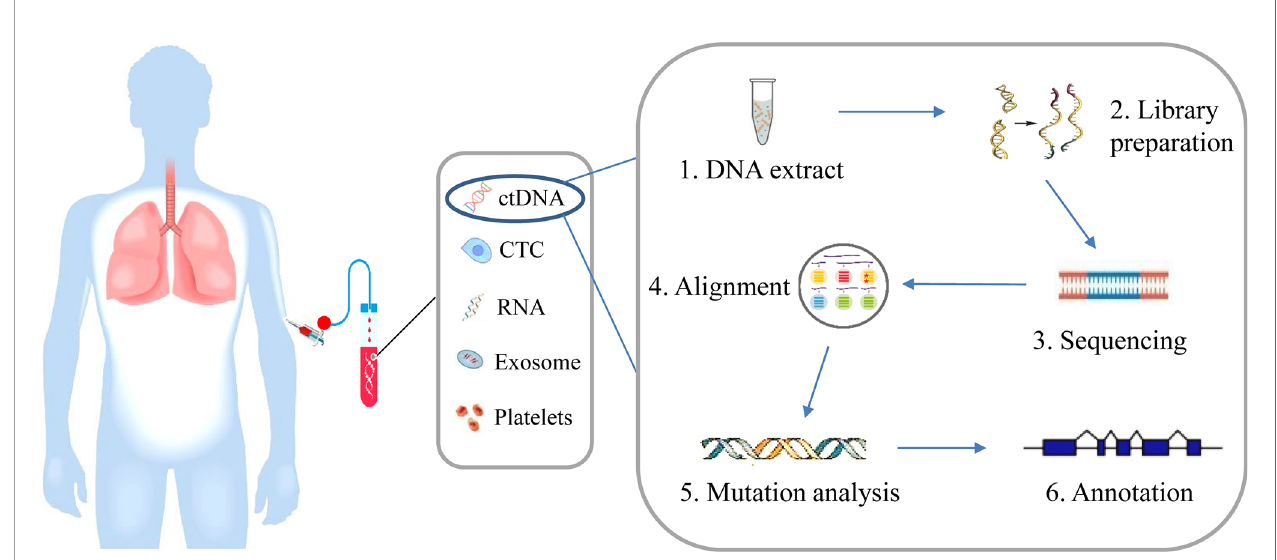
FIGURE 1 | Overview of liquid biopsy. Blood is sampled from patients, which contains ctDNA, CTC, RNA, exosome, and tumor-educated platelets. CtDNA is extracted from blood plasma and gene variation can be analyzed by next generation sequencing involving a few steps, including DNA extraction, DNA library preparation, sequencing, sequence alignment, mutation annotation, and so